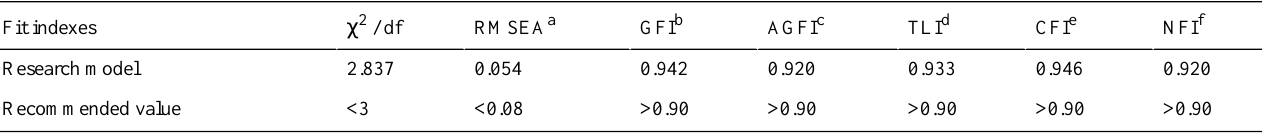
Table 4. Goodness-of-fit results of the revised research model.